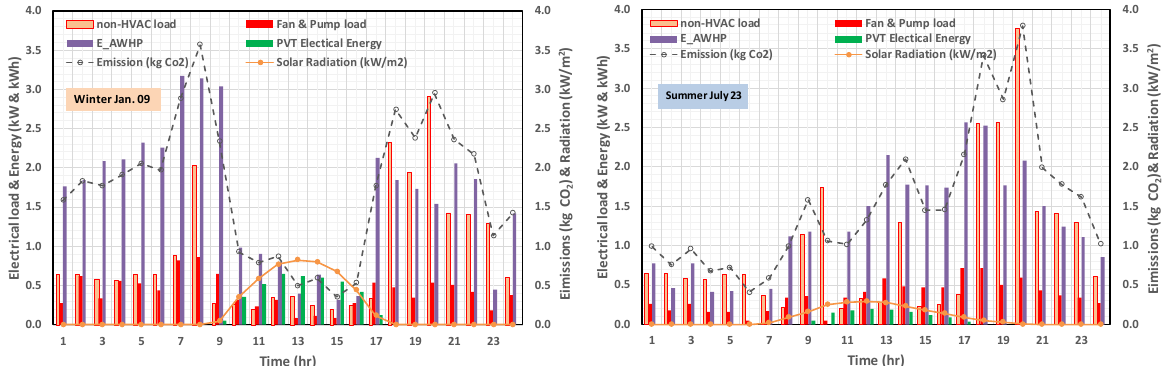
Figure 6. Hourly HVAC and non-HVAC energy consumption, energy production, CO 2 emissions and solar radiation under Incheon weather conditions for coldest and warmest days and under optimum design conditions.